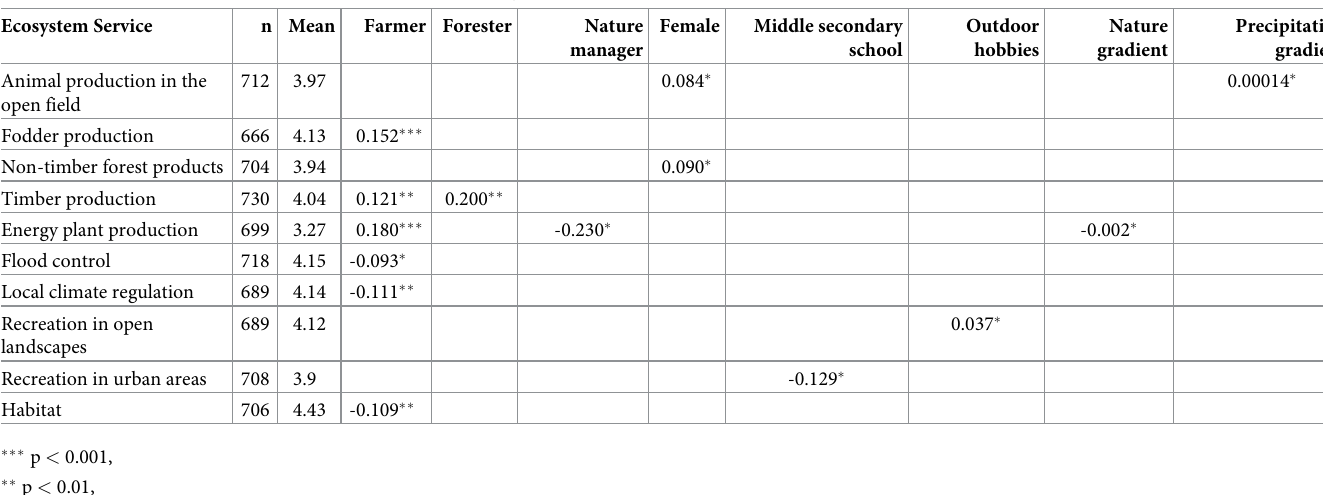
Table 2. Coefficients from the Generalized Linear Models. The coefficients for the group of farmers, foresters, and nature managers are to be interpreted relative to the group of citizens. The reference level for middle secondary school is the higher secondary school category. Knowledge on ES was never significant and is therefore not shown. Spatial distributions of residuals are shown in S31-S40 Figs in S1